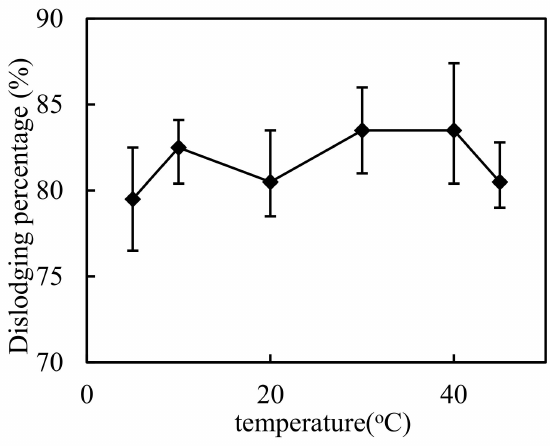
Figure 3. The impact of